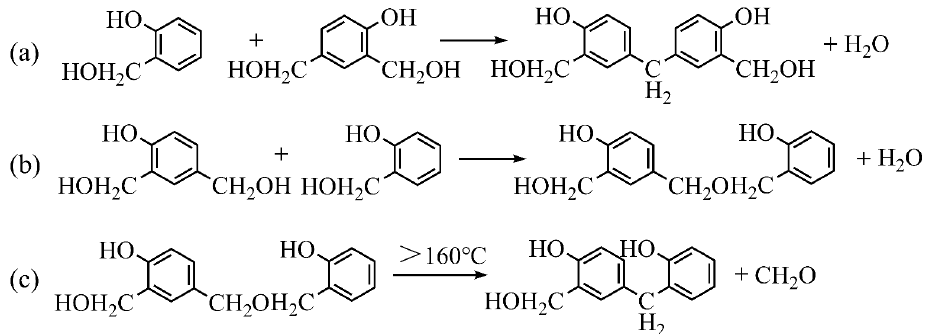
Figure 9. Chemical reactions occurring during thermal curing of the PF resin.